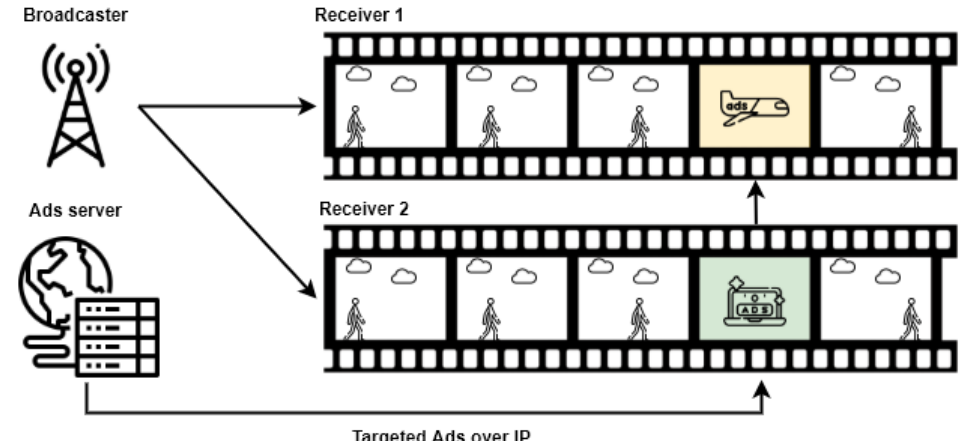
Figure 3. HbbTV targeted ads